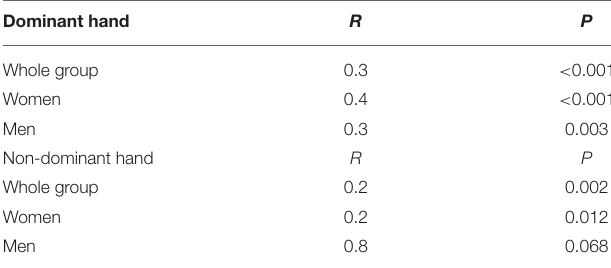
TABLE 4 | The values of TOWL measurements in the whole group, in the group of women, and in the group of men. Whole group Type of finger Mean ± SD [c.u.] Min [c.u.] Max [c.u.]